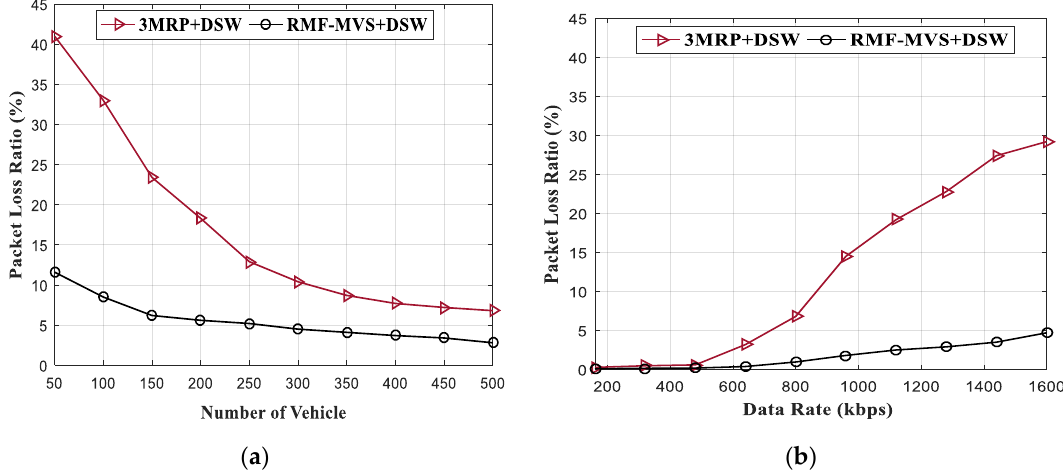
Figure 10. Packet Loss Ratio (PLR) based on Varied Number of ( a ) Vehicles and ( b ) Data Rates Considering Dynamic Weighting Score.